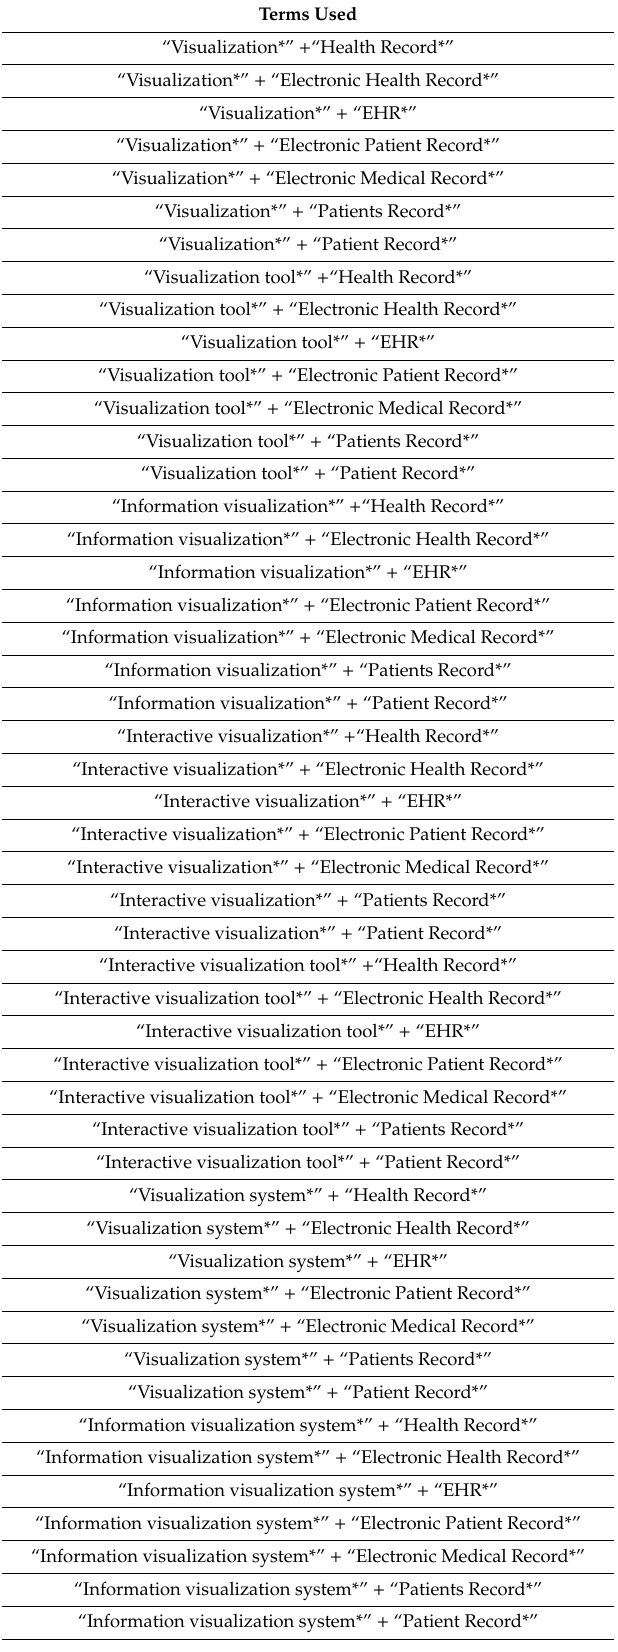
Table 2. Overview of the search terms